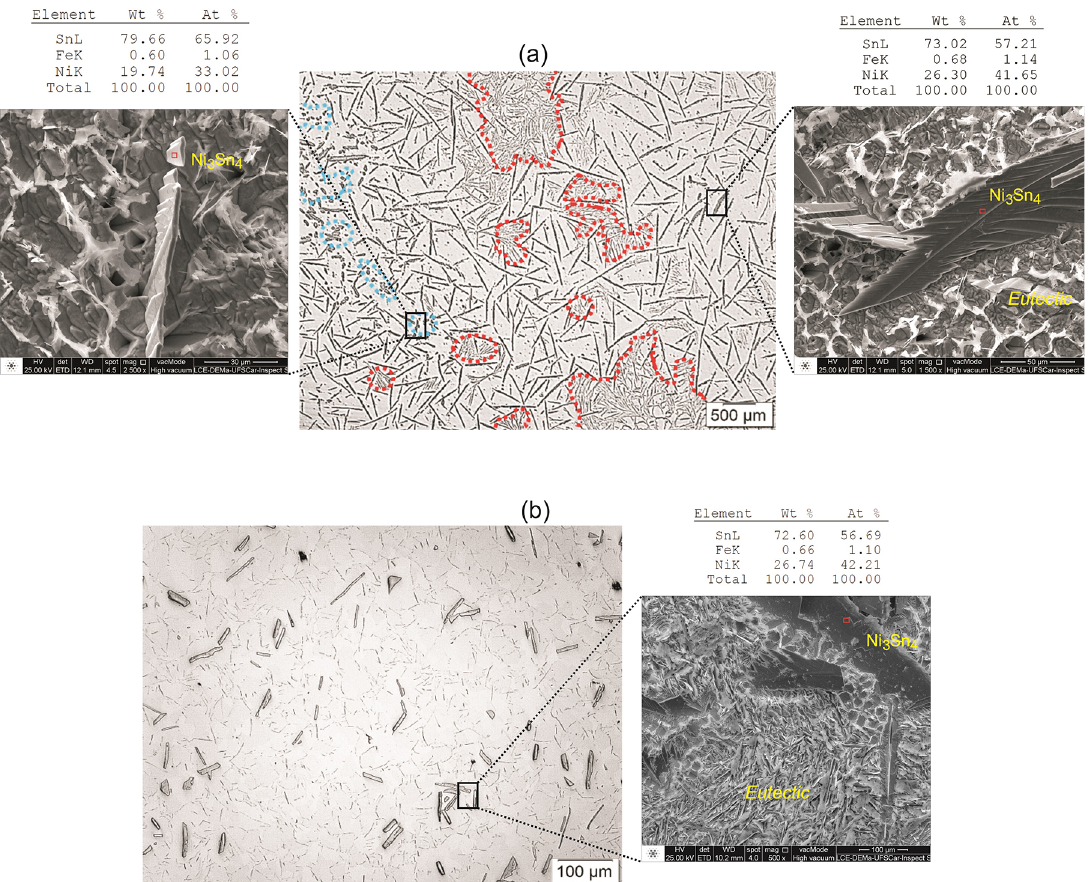
Figure 10. Transverse optical and SEM-EDS microstructures emphasizing the formed Ni3Sn4 primary phase along the length of the Sn- 0.5wt.%Ni alloy casting: (a) P=5mm and (b) P=40mm, where P is the position from the cooled surface of the alloy